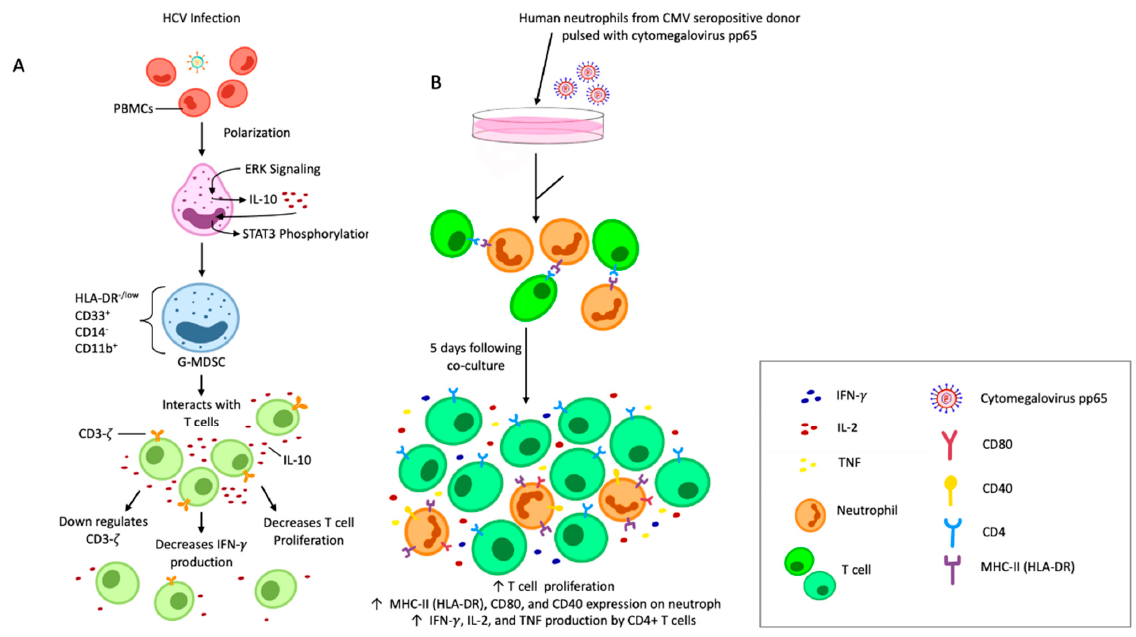
Figure 3. Neutrophils are heterogeneous, with each subset exerting specific immunomodulatory functions during viral infections such as those caused by hepatitis C virus (HCV). ( A ) Granulocyte myeloid-derived suppressor cell polarization occurs through activation of the extracellular signal- regulated protein kinase (ERK)-1/2 mitogen-activated protein kinase (MAPK) pathway, with further augmentation by IL-10-dependent signal transducer and activator of transcription (STAT)-3 phos- phorylation. Eventually, the proliferation of autologous T cells and production of IFN- γ are re- pressed, leading to persistence of HCV [111]. ( B ) Human neutrophils can also function as antigen- presenting cells. Neutrophils pulsed with the cognate antigens pp65 from cytomegalovirus (CMV) or influenza hemagglutinin were able to present the antigens to autologous antigen-specific CD4 + T cells via major histocompatibility complex (MHC) class II and induce proliferation of helper T cells at a low but consistent rate both in vitro and ex vivo [139].